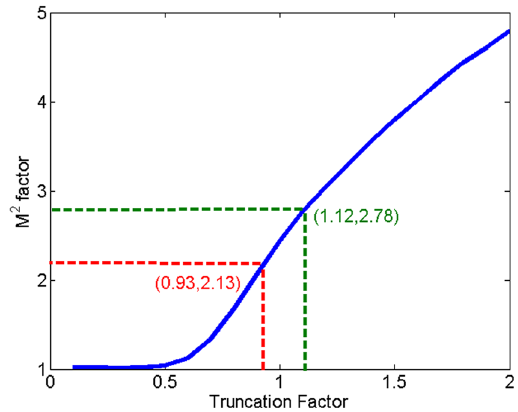
Figure 3. The classic M2 factor of the truncated Gaussian beam as the function of truncation